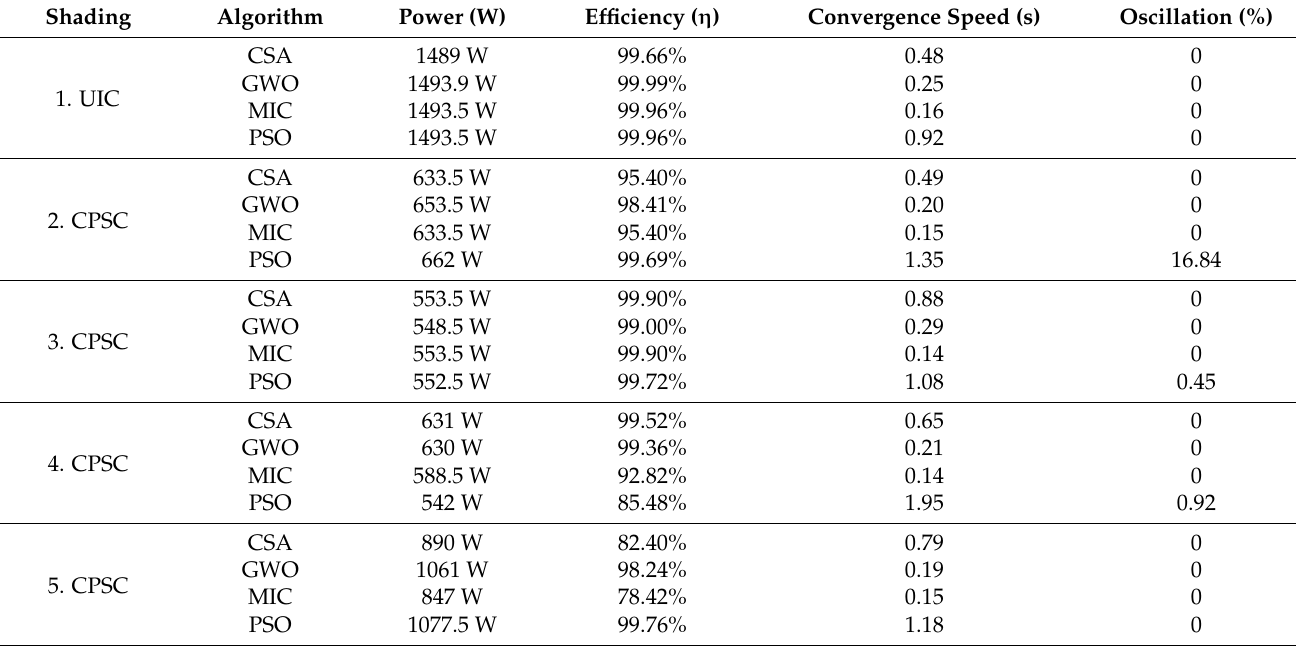
Table 3. Comparison of CSA, GWO, MIC, and PSO